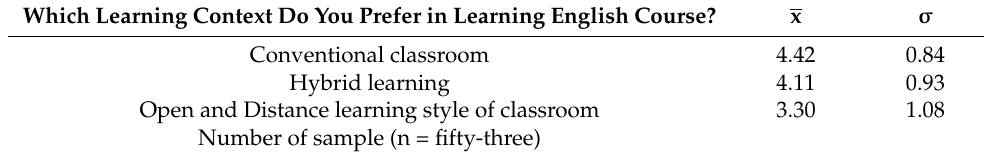
Table 3. The Learning Context Preference in an English Course.